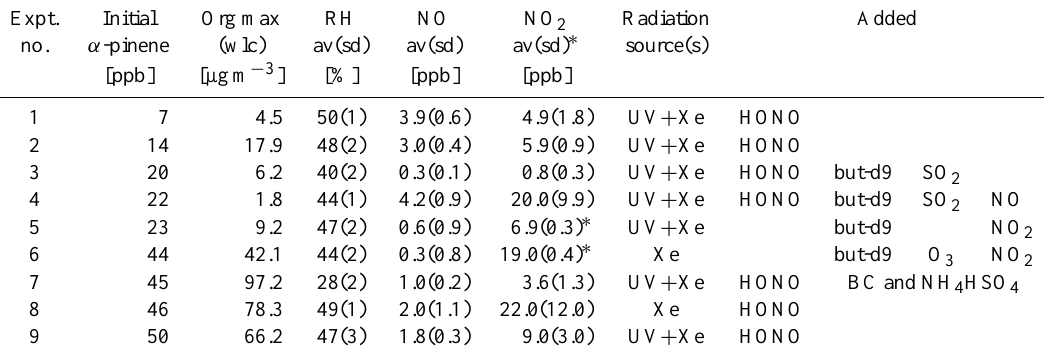
Table 1. Overview of experiment conditions. Org max (wlc) is the wall-loss-corrected organic mass concentration at the end of the ex- periment. Radiation sources are UV or xenon (Xe) lights. The OH tracer butanol-d9 is abbreviated with but-d9. Black carbon (BC) and NH 4 HSO 4 represent seed aerosol in experiment